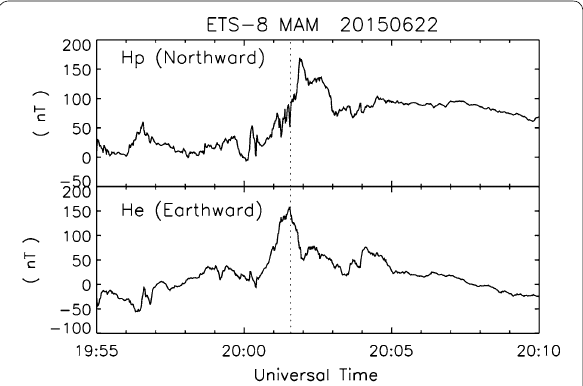
Fig. 9 Zoomed in plots of Hp and He (Earthward) at around the tail magnetic dipolarization. The rapid decrease in He (dotted line) occurs concurrently with the rapid increase in Hp, which signifies a reconfiguration of the tail magnetic field at the onset of